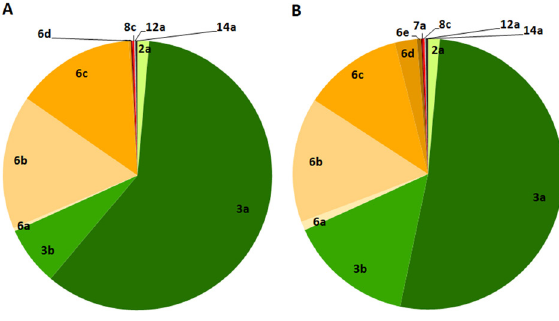
Fig. 6. Landscape subtypes structure in the study area developed by the audit method (A) and modified method (b). Explanations of landscape subtypes in